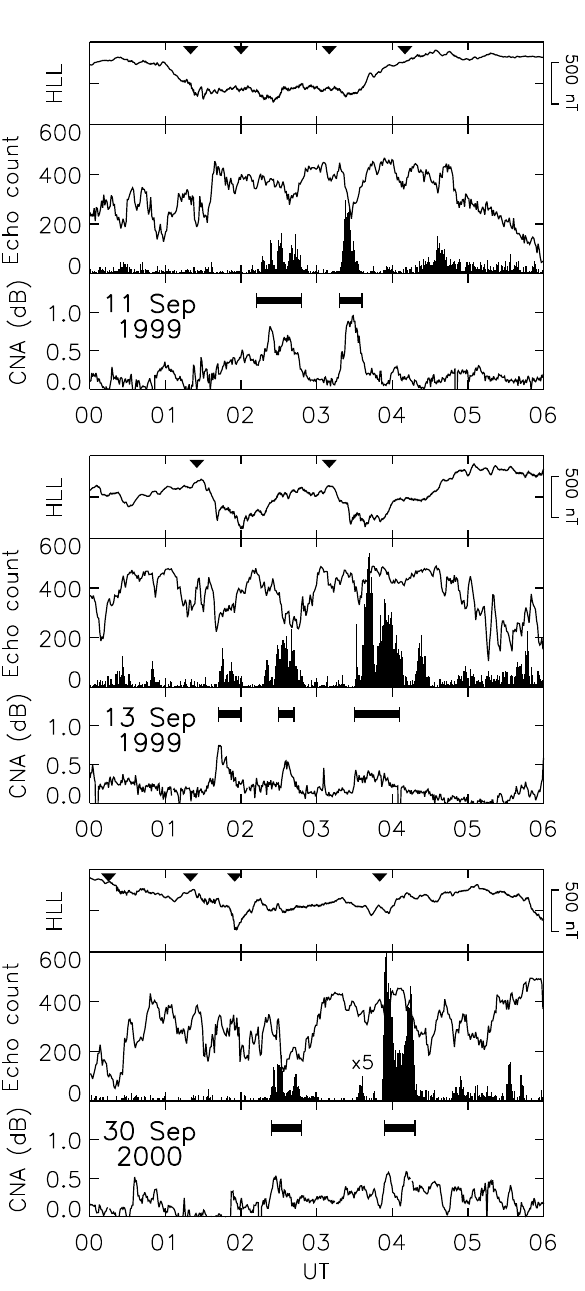
Fig. 4. Three examples of the correspondence between riometer absorption and the occurrence of D region radar echoes. In each set of three panels: (upper panel) the H component magnetic field measured by the HLL magnetometer of the SAMNET network; tri- angles indicate the times of significant Pi2 activity; (middle panel) the total number of E region echoes seen (solid curve) and the num- ber of D region echoes (black histogram, values multiplied by 5); (lower panel) the riometer absorption measured while it was oper- ating in a vertical wide-beam